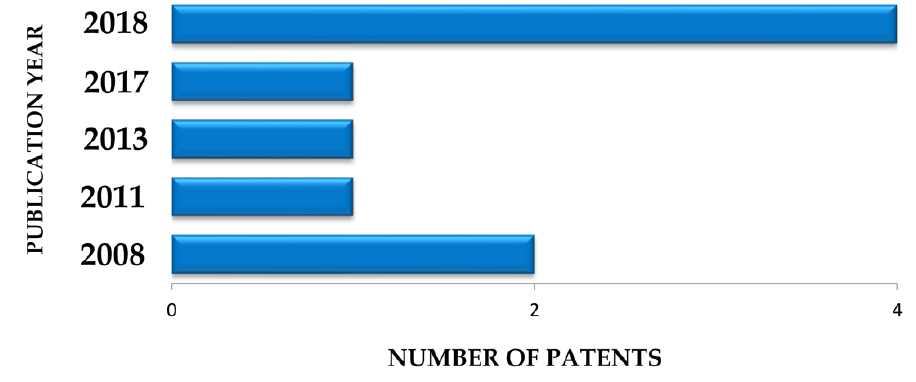
Figure 5. Number of patents reporting pharmacological activities of Euterpe oleracea Mart. 487